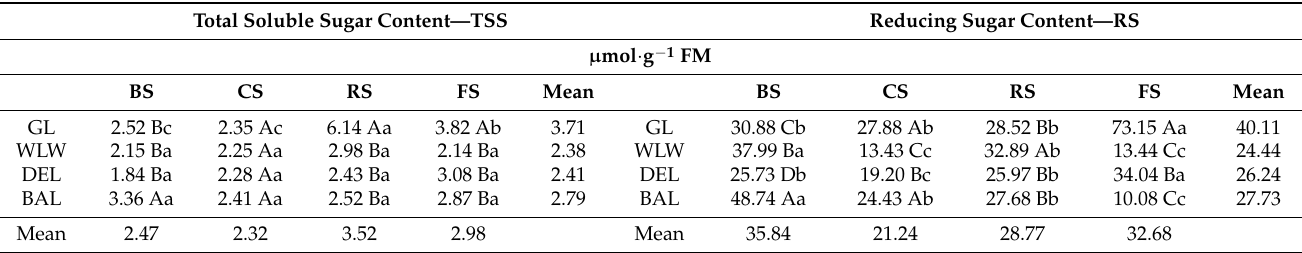
SV, source of variation. * Significant at 5% probability ( p ≤ 0.05) . The accumulation of carbohydrates observed by the content of total soluble sugars (TSS) and reducing sugars (RS) was higher in the Great Lakes cultivar in the full sun (FS) environment with about 78 µmol·g −1 of commercial fresh matter (CMF) and shaded with the red screen (RS), with 6.40 µmol·g −1 , respectively (Table 2). Table 2. Total soluble sugar content (TSS) and reducing sugar content (RS) of iceberg lettuce cultivars under different shade screens.